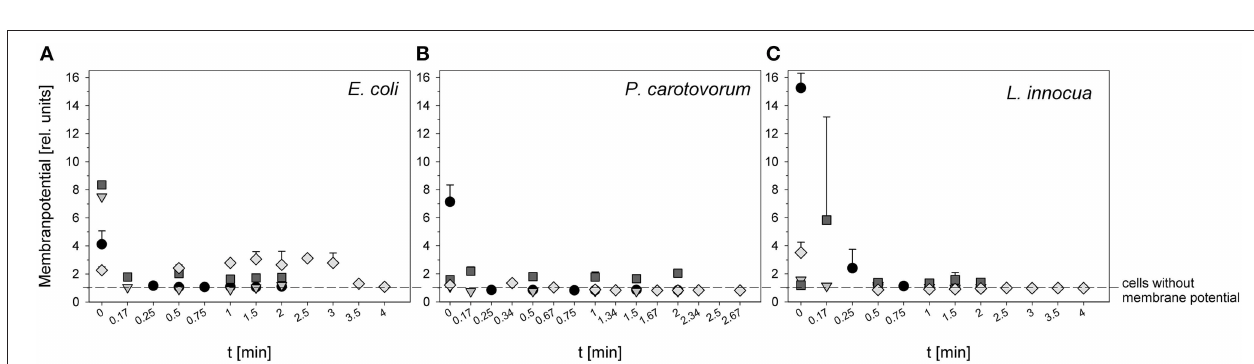
FIGURE 1 | Total viable count of E. coli (A), P. carotovorum (B), and L. innocua (C) after PAA treatment (circles: 10 ◦ C, 0.25% PAA), CAPP treatment (rhombus: 20 W), and treatment with ozonated water [triangle: 3.8 ± 1.02mg l − 1 O 3 (–); square: 3.8 ± 1.02mg l − 1 O 3 ( + )]. The lines represent the inactivation obtained by the GInaFit tool.